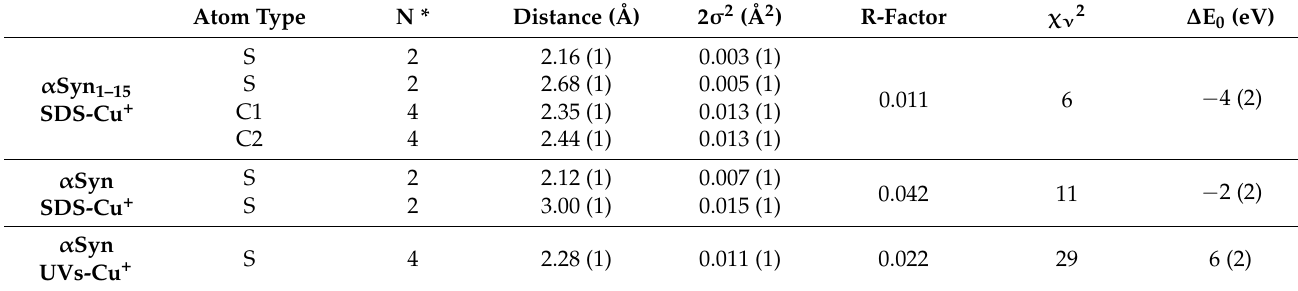
Table 1. Fitting results of the experimental EXAFS spectra reported in Figure